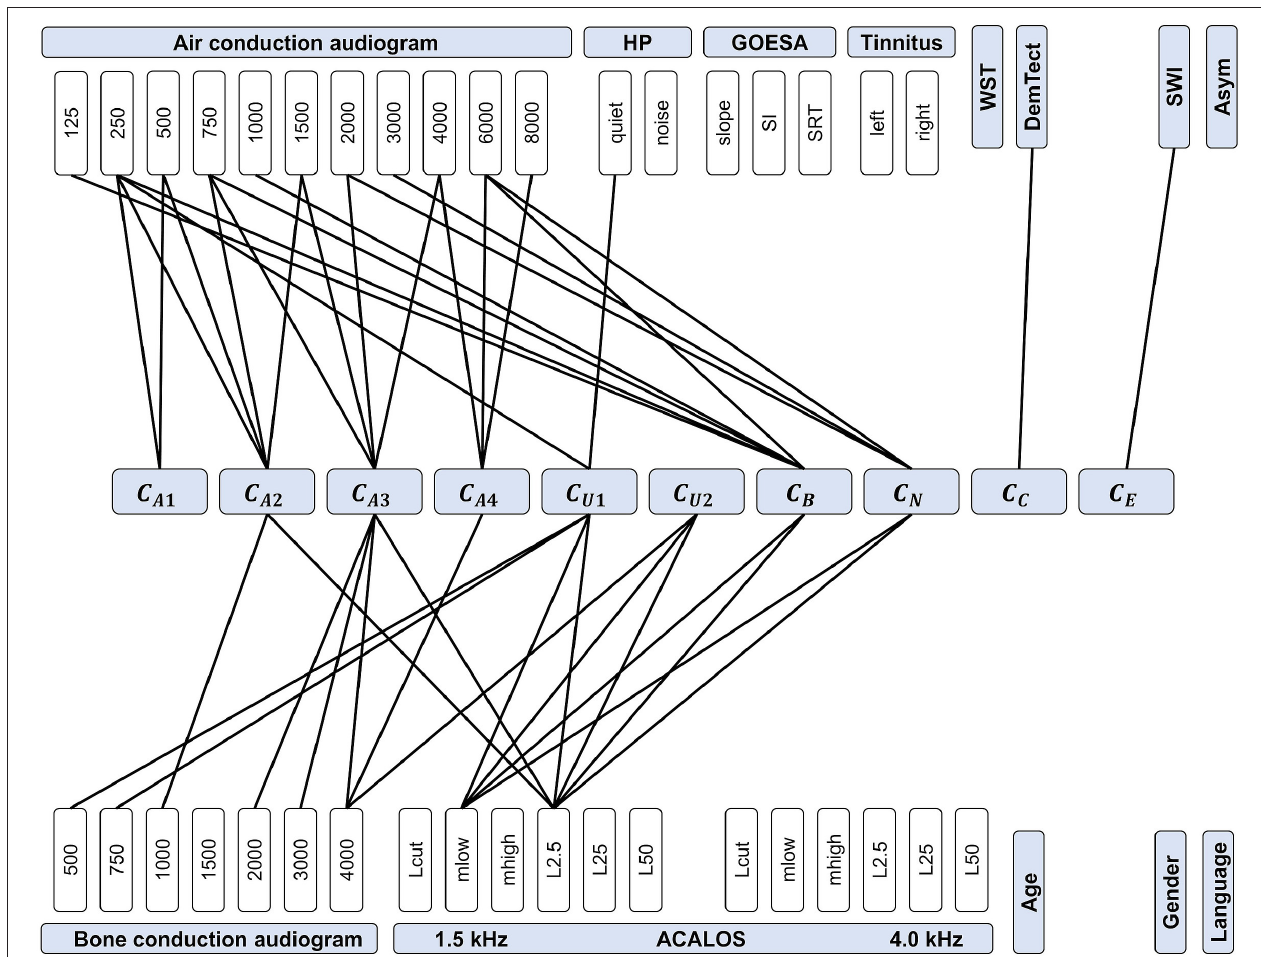
FIGURE 8 | Feature importance for predicting CAFPAs. CAFPAs are displayed in the center of the figure; features in the upper and bottom parts. Measurement parameters are represented by white boxes (cf. Table 1 for abbreviations and units). Black lines displayed as connections between the measures and the CAFPAs indicate features selected by all three models to be relevant for the prediction of the respective